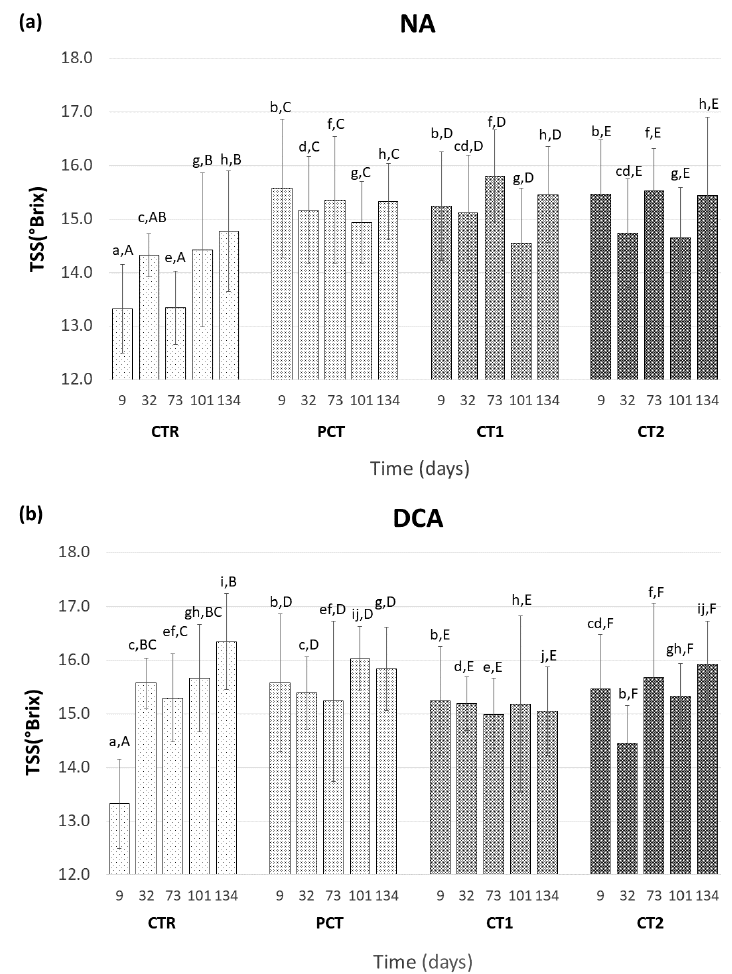
Figure 4. Evolution of total soluble solids (TSS) of “Rocha” pears at 9, 32, 73, 101, and 134 days. ( a ) NA (normal atmosphere); ( b ) DCA (dynamic controlled atmosphere) storage conditions. For each type of storage, four coating conditions are presented as follows: CTR (control), PCT (pectin), CT1 (coating 1), and CT2 (coating 2). Values are mean ± SD of ten replicates. The values followed by the same lowercase letter indicate no significant differences at the same sampling time between storage conditions, and by the same uppercase letter indicate no significant differences between sampling times within each coating condition (LSD test at p < 0.05).